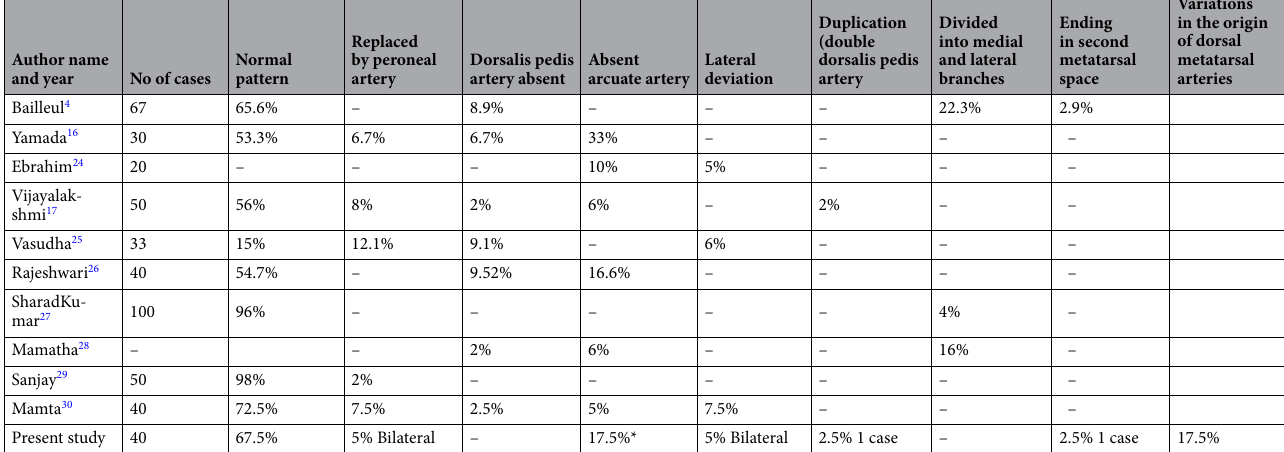
Table 1. Showing compilation of the data available on the variations of dorsalis pedis artery in origin, course and branching pattern published in the literature till date and comparing them with the present study variations. * In the same specimen where dorsalis pedis artery was replaced by peroneal artery right limb, arcuate artery was absent in the right